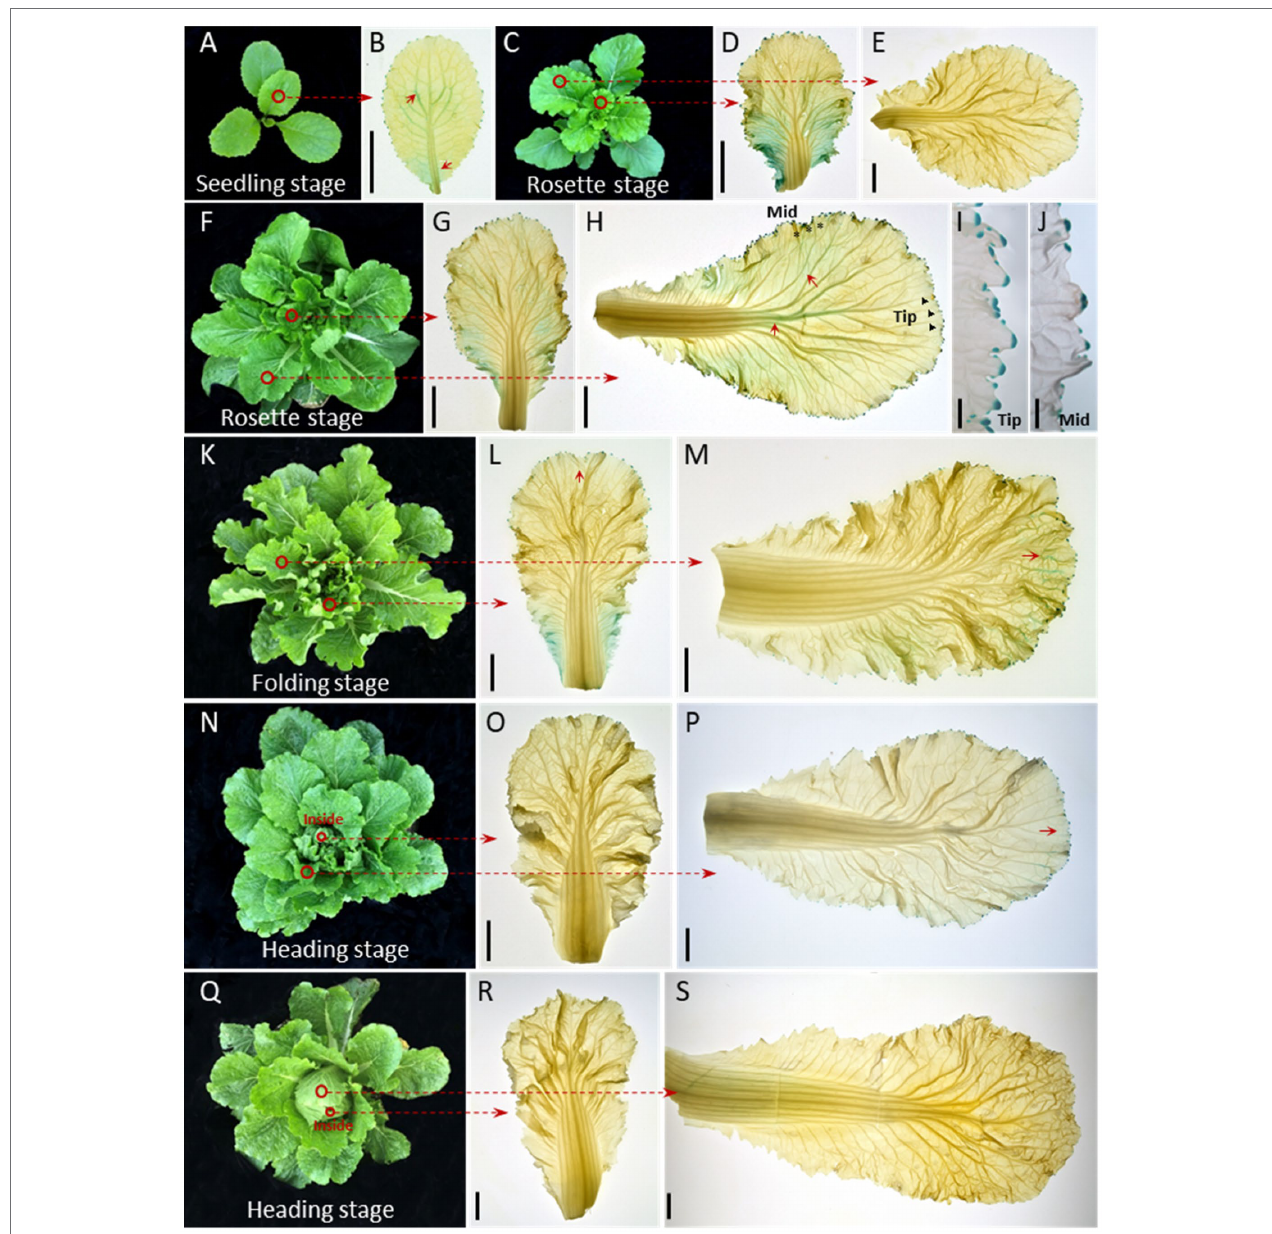
FIGURE 1 | Auxin is dynamically distributed in the Chinese cabbage leaf during growth. Expression pattern of DR5::GUS in seedling (28 days old) (A) , rosette (44 and 50 days old, respectively) (C–J) , folding (57 days old) (K–M) and heading (67 and 87 days old, respectively) stage leaves (N–S) . The 1st-2nd innermost leaves (B , D , G , L , O , R ) and the 3rd-5th outermost leaves of the plants were harvested for GUS staining (E , H , M , P , S) . For inner leaves, the DR5::GUS signals were expressed over almost the entire leaf at the seedling and rosette stages (B,D,G) , then gradually decreased (L,O,R) . For the outer leaves, the GUS signals were visible around the whole leaf edge (E,H) and converge on the leaf apex especially after the leafy head formed ( P , red arrows). The GUS signals in leaf veins shifted from the middle to the apical part of the leaf (H , M) and show a net-like pattern prior to leaf curling (H) . (I,J) Show magnified vies of the leaf tip (black triangle) and mid-margin (abbreviated to Mid, black asterisk) from (H) . Red circles indicate the leaves used for GUS staining. The short red arrows show the areas with strong GUS staining signals. Scale bars: 2 cm (B,D,E,G,H,L,M,O,P,R,S) , 2 mm (I,J)